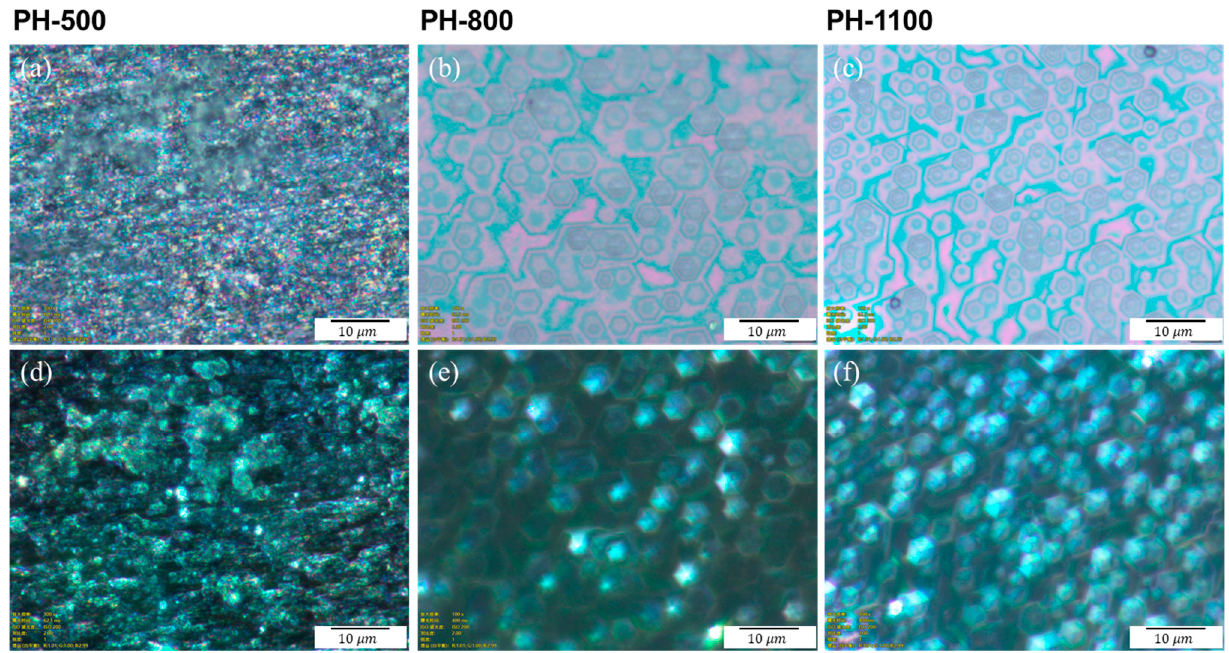
Figure 5. Optical microscopic images with 100× magnification of the 1- μ m GaN film fabricated on the PH-500, PH-800, and PH-1100 substrates: ( a – c ) bright- and ( d – f ) dark-field OM images.